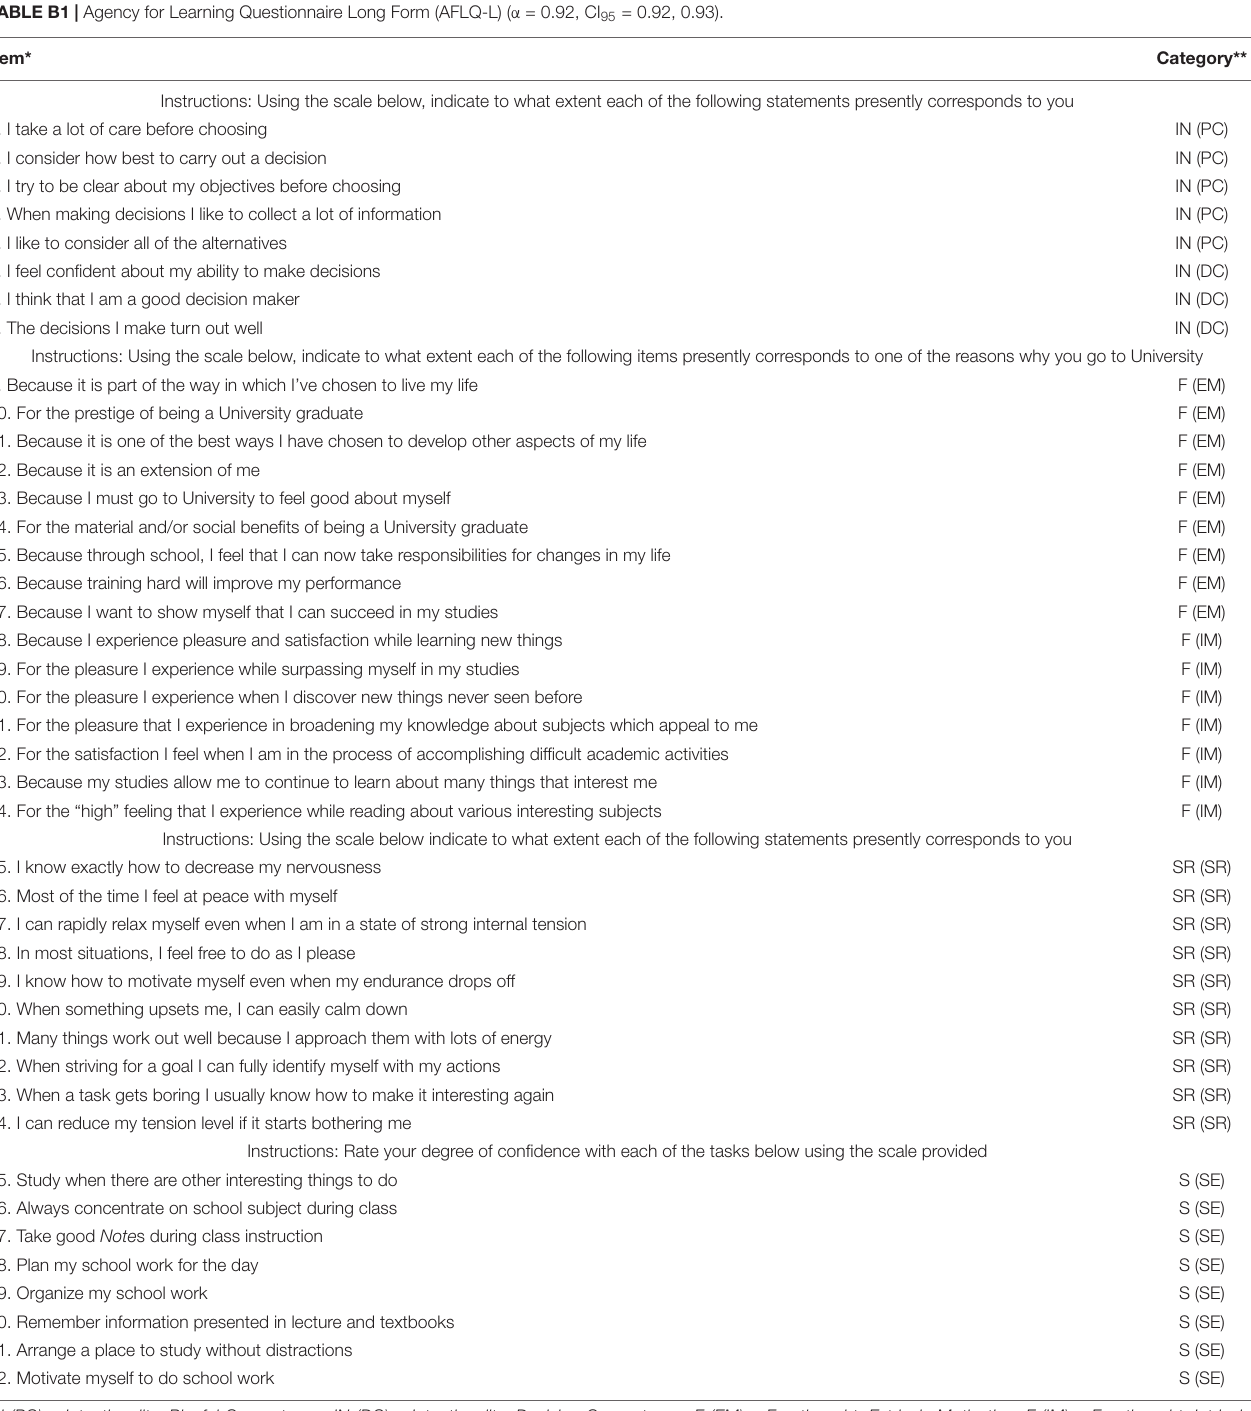
TABLE B1 | Agency for Learning Questionnaire Long Form (AFLQ-L) ( α = 0.92, CI 95 = 0.92,